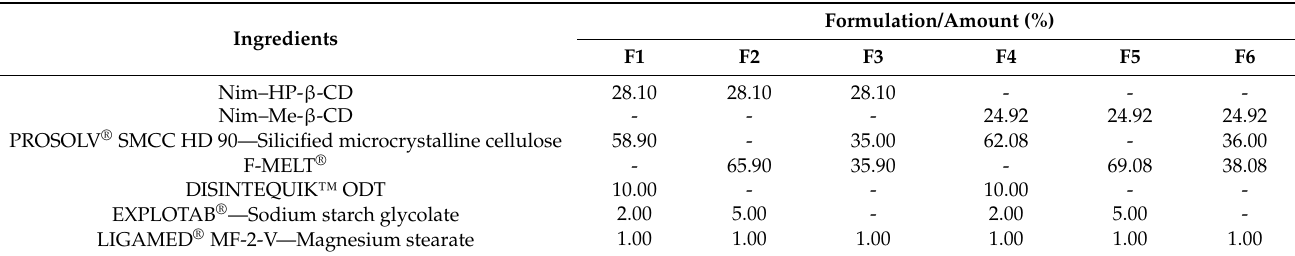
Table 1. The formulations of the direct compression mixture with Nim–HP- β -CD and Nim–Me- β -CD inclusion